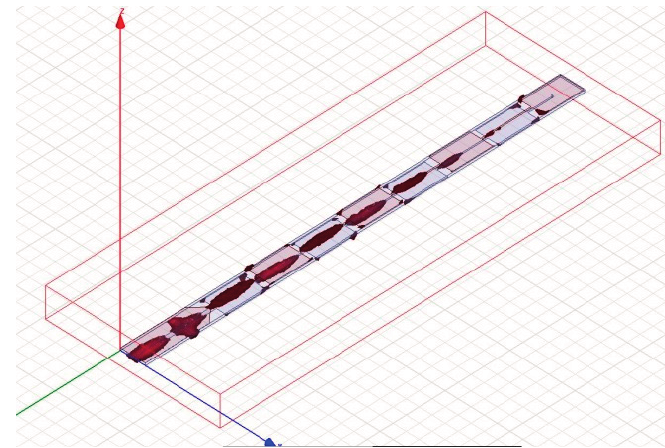
Figure 3. Simulation result of near-field radiation.